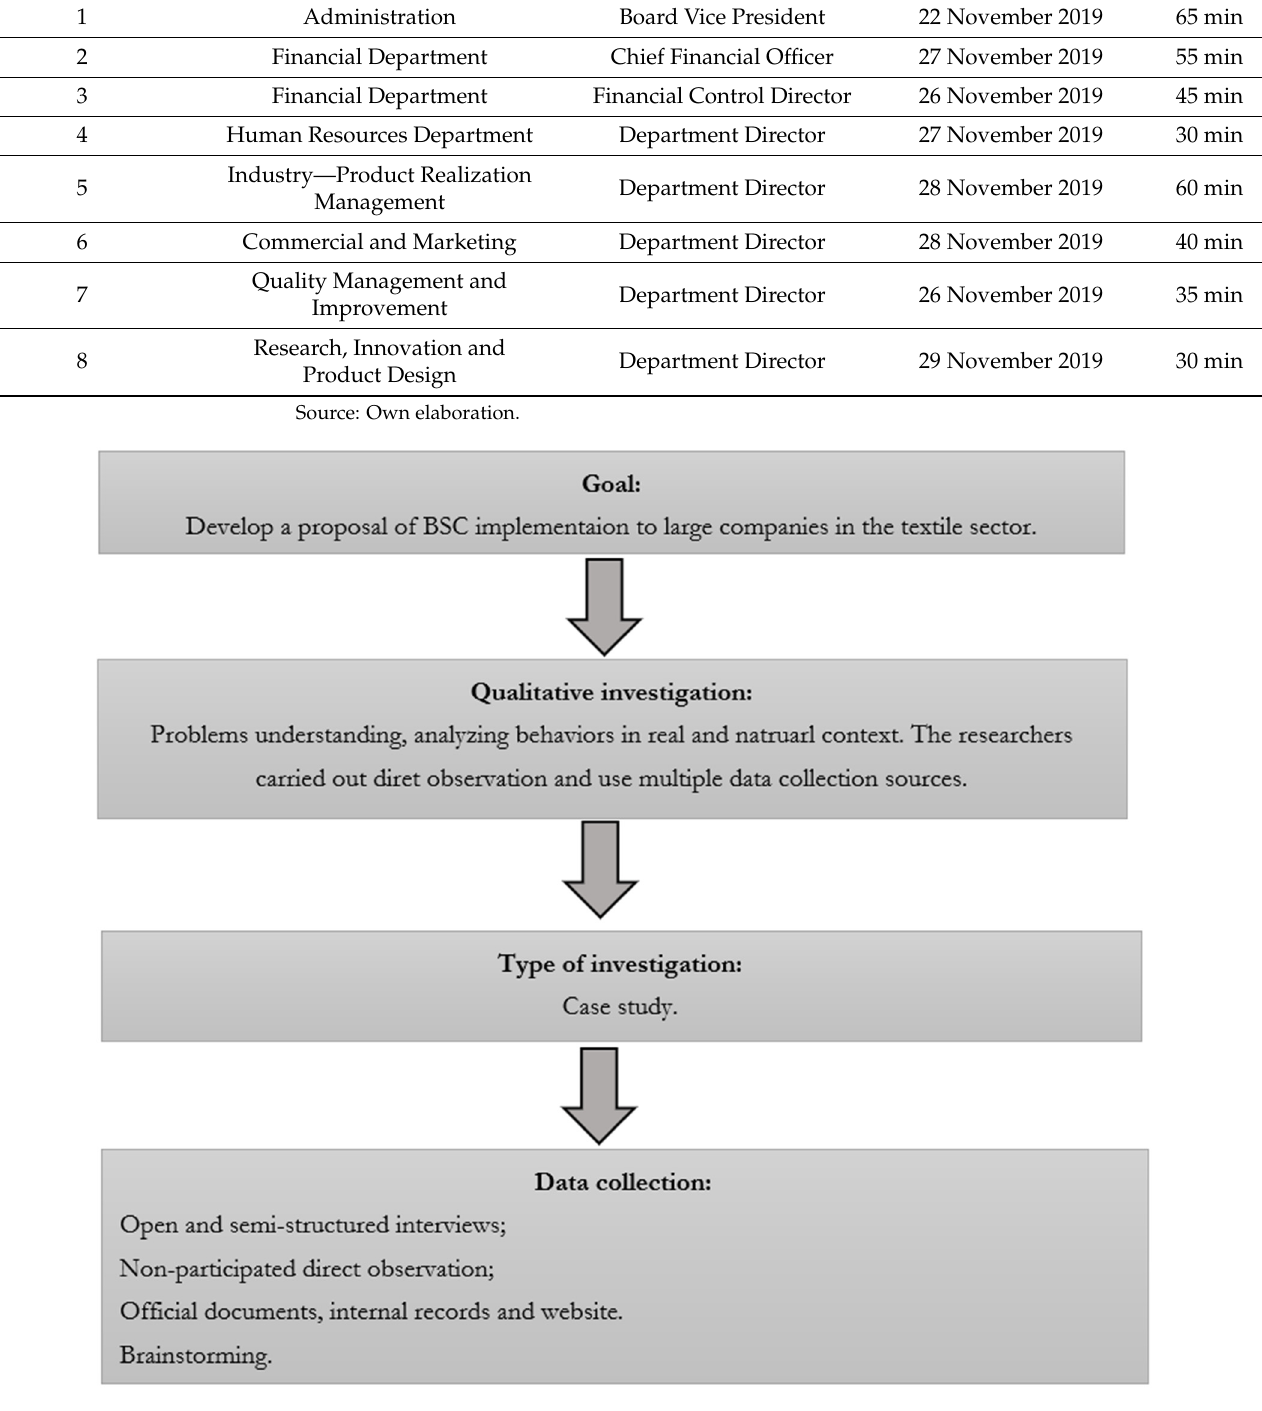
Figure 1. Methodological stages. Source: Own elaboration.